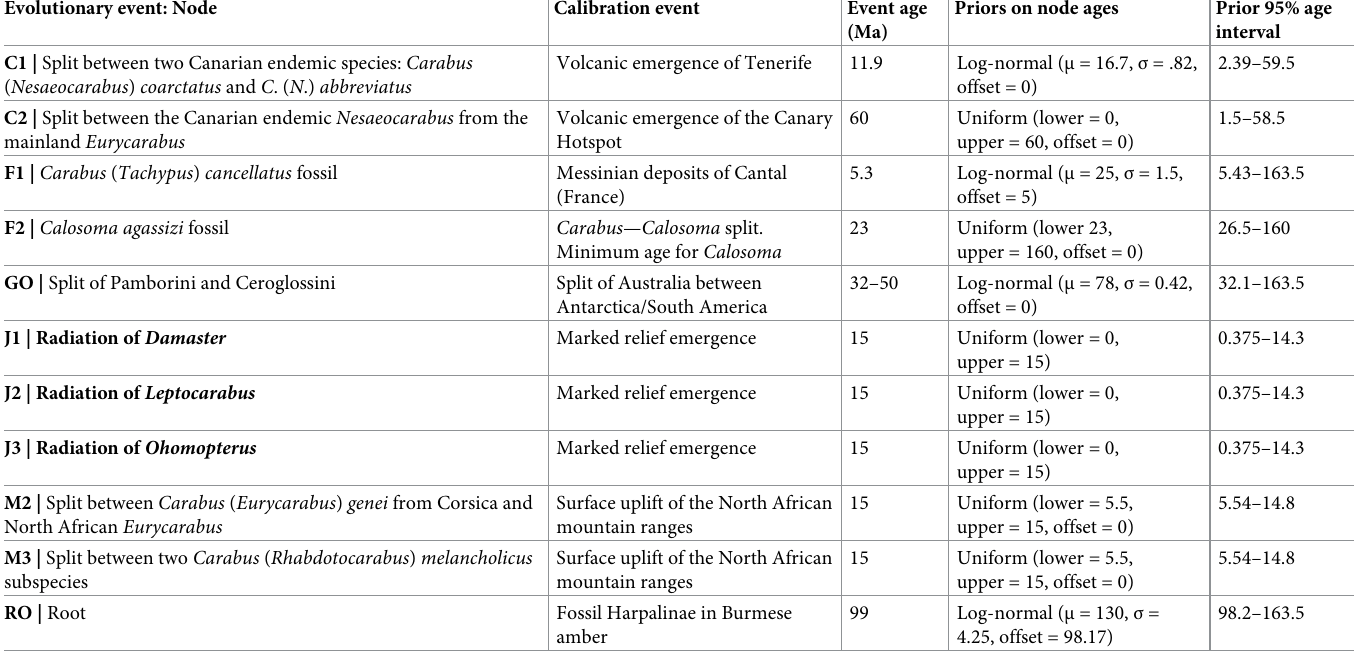
Table 2. Calibration strategy of this